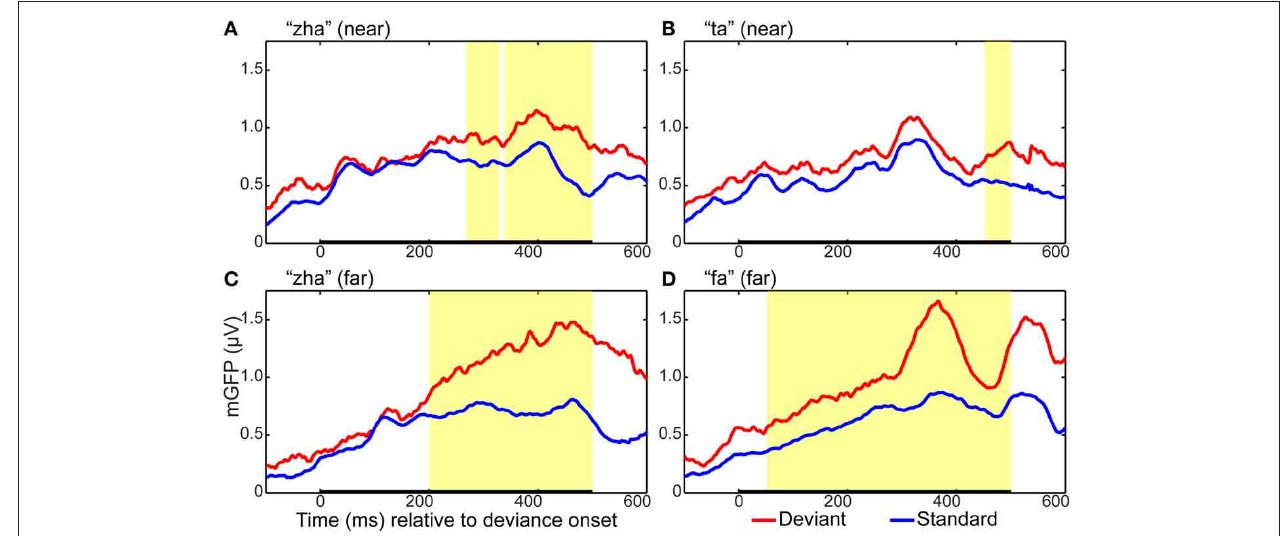
difference ( p < 0 . 05) between standard and deviant GFPs, as determined by a permutation test corrected for multiple comparisons over time. Statistical comparisons were performed over the times indicated by the heavy black line along the time axis. This time window was selected to include the expected time for a vMMN evoked by the consonant part of the